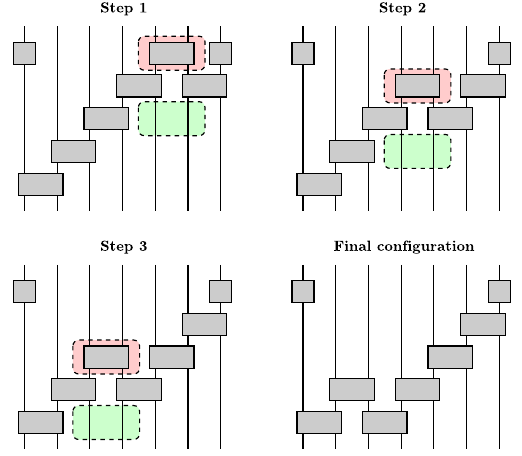
FIG. 19. Example of a transformation from the configuration mutation relations and cyclic permutations, we must transform the operator in the red box to the position denoted by the green